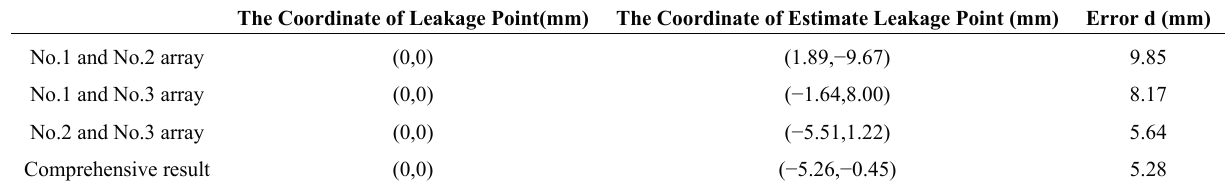
Table 5. Leakage location results.